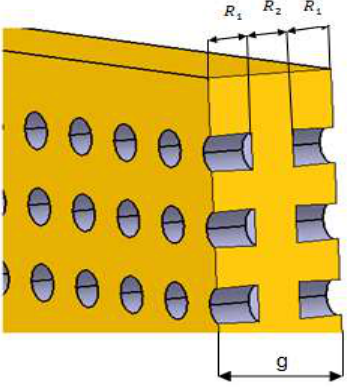
Figure 3. Panel with partly perforated symmetric channels.